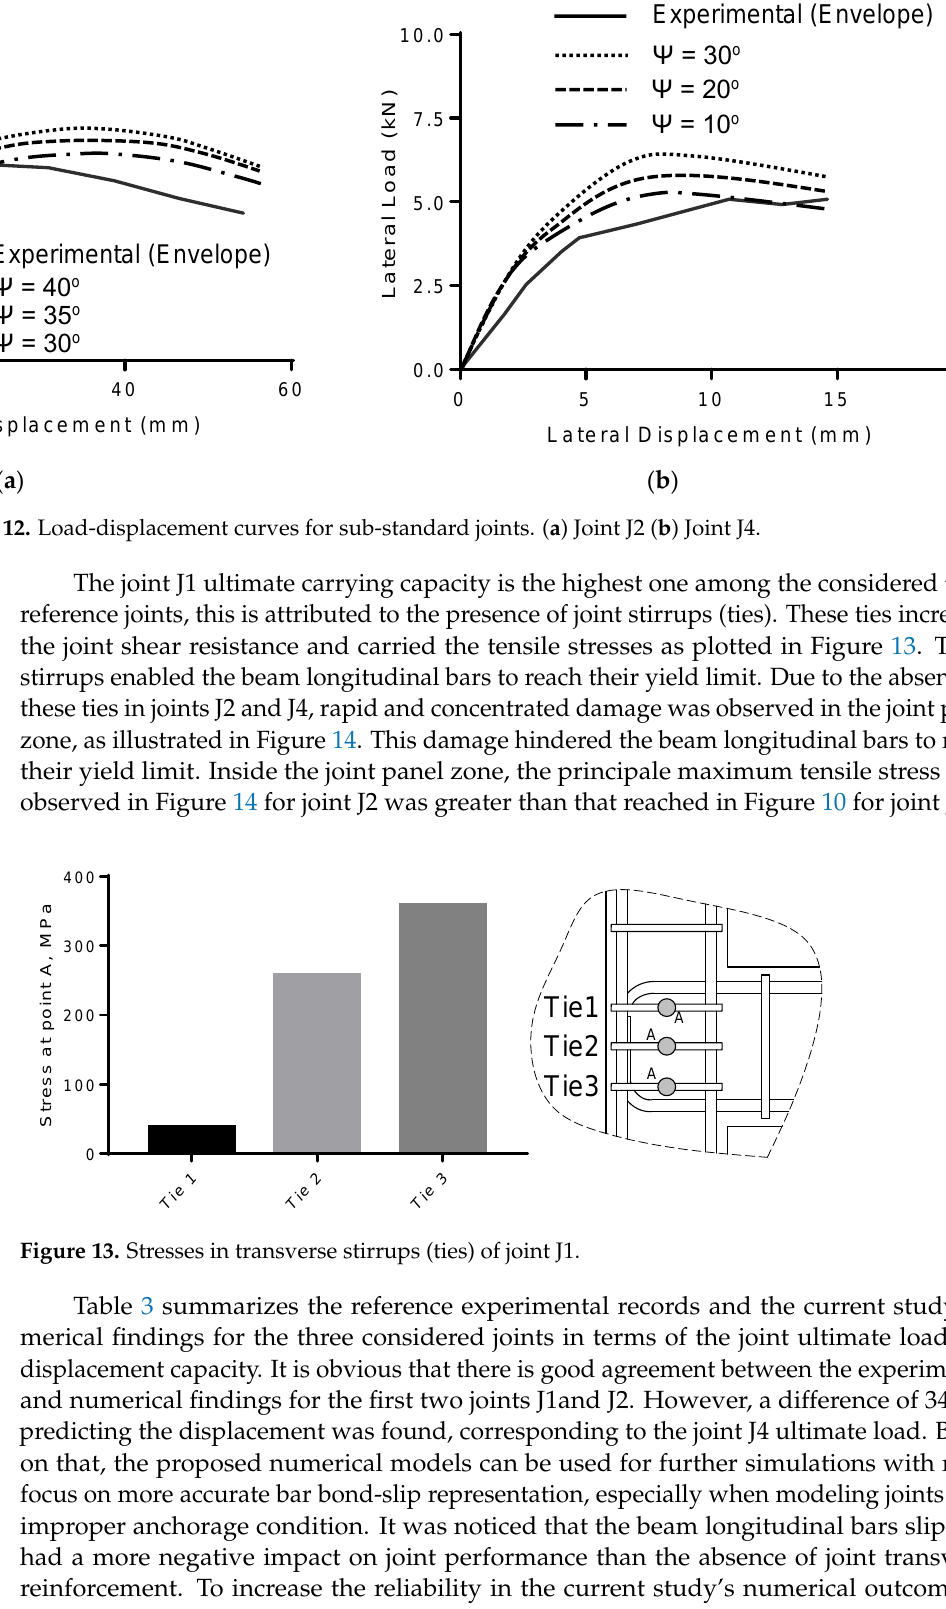
comparison to other empirical/analytical equations was made. In this reference joints, the brittle shear failure is the predominant mode. Based on the the general forces